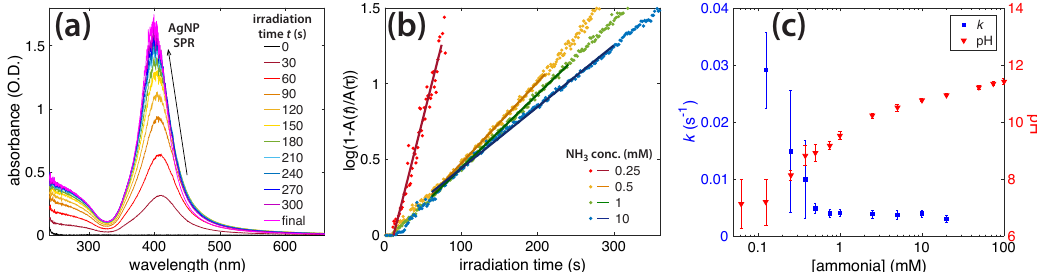
Figure 3. ( a ) Absorbance peak of silver nanoparticles (AgNPs) in 1 mM NH irradiation; ( b ) AgNP formation rates in different concentrations of ammonia; ( c ) Rate constant as a function of NH concentration, overlaid with the initial pH of Ag–NH 3